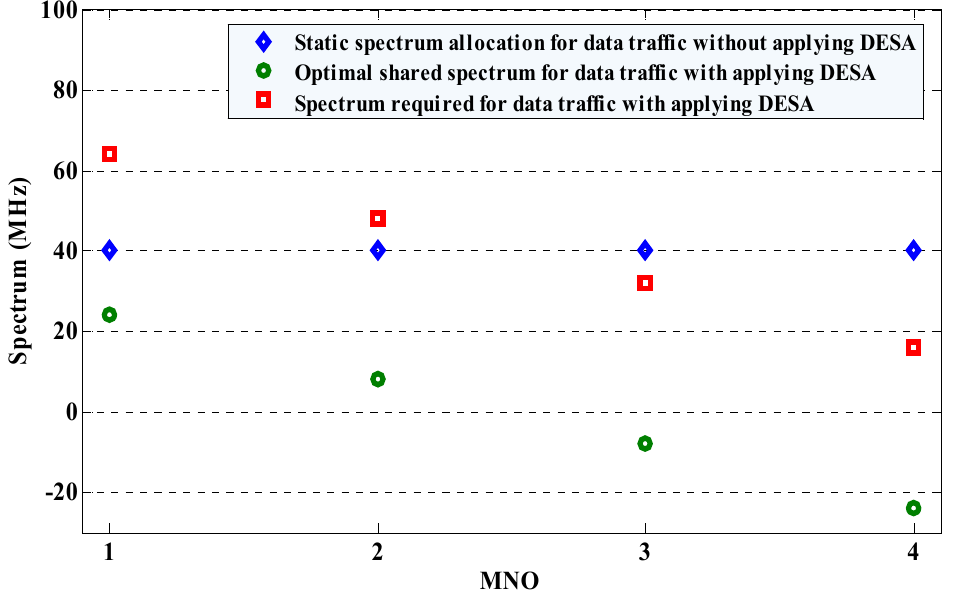
Figure 4. The spectrum redistribution to all MNOs in a country with applying